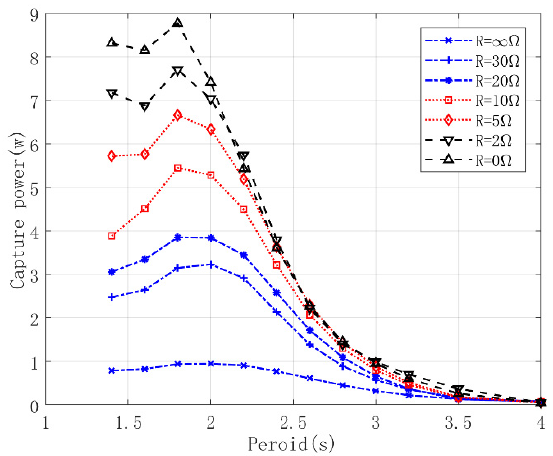
Figure 21. The captured power of THP1 with different LRs.